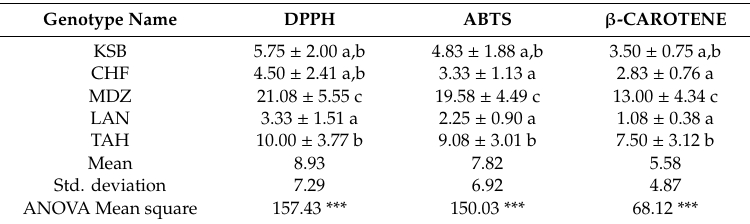
Table 5. Free radical scavenging activity assessed by DPPH, ABTS, and β -Carotene blanching essay investigated in fruits of sampled strawberry tree genotypes. Results are expressed as mean ± SD in mg Ascorbic acid equivalent (AAE) / g DW.